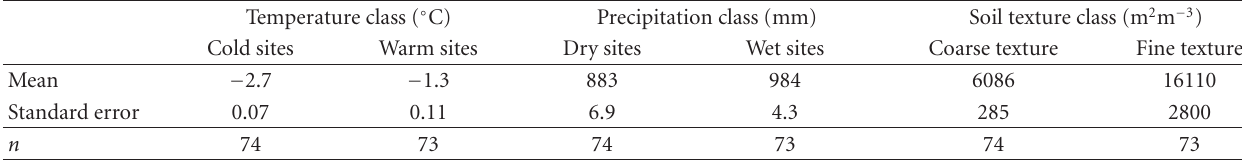
Table 1: Mean, standard error and number of plots included in air temperature, precipitation, and soil texture